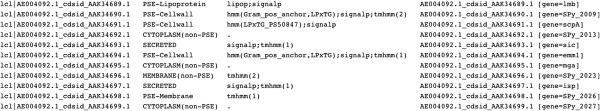
An example of inmembrane output using the gram_pos protocol.